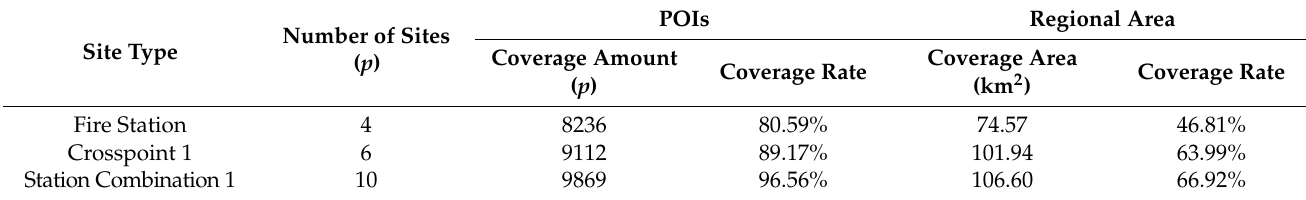
Figure 8. Results of the first fire station location simulation. Table 3. Coverage of POI and area by Crosspoint